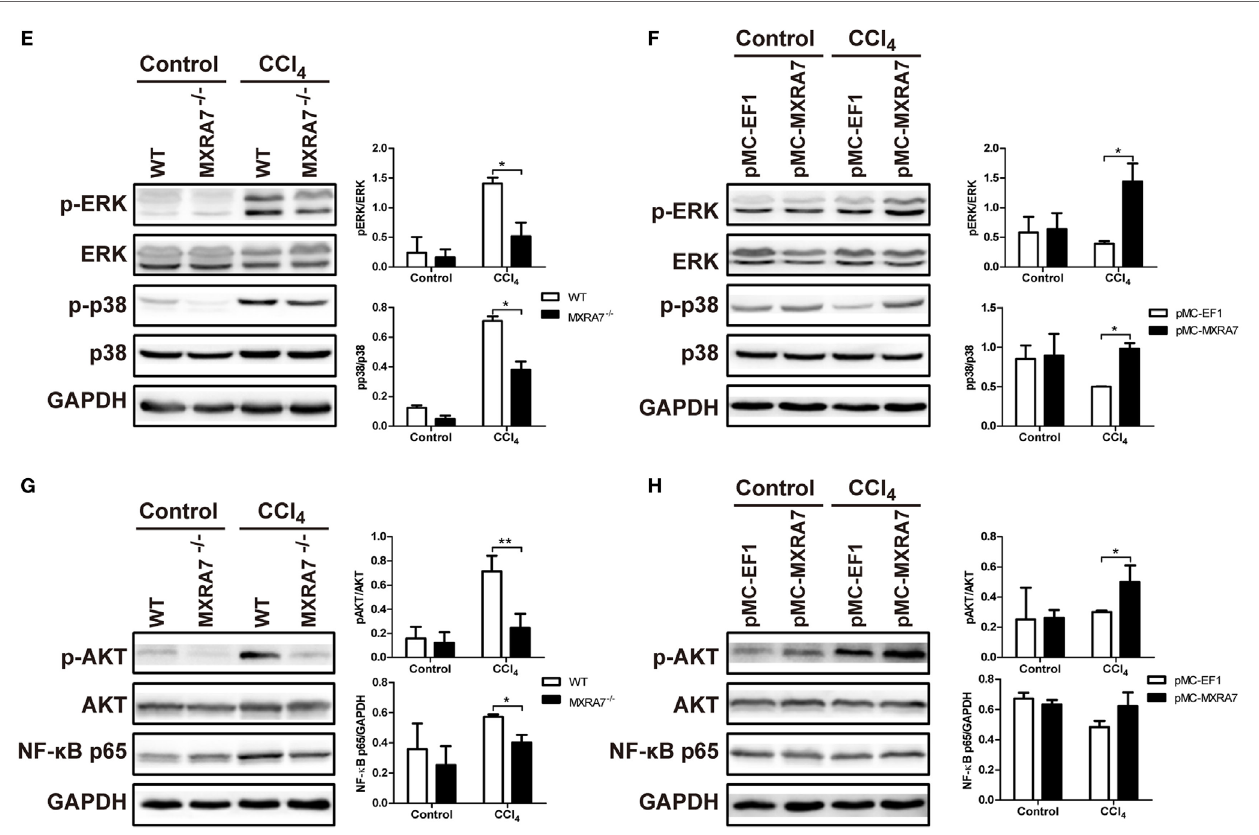
FigUre 7 | Matrix remodeling associated 7 (MXRA7) deficiency suppresses the cell apoptosis pathway and inflammatory pathway in livers. Livers were harvested from different groups of mice 24 h after 1 ml/kg CCl 4 injection. (a,B) Hepatocyte apoptosis in liver was analyzed using TUNEL staining (in red). Representative images from different groups are shown. Scale bar = 100 μ m. And proteins were extracted from livers for western blot analysis of Bax and Bcl-2 (c,D) p-ERK, ERK, p-p38, p38 (e,F) , p-AKT, AKT, and NF- κ B p65 (g,h) . Representative images shown are the representative of three independent experiments. * p < 0.05, ** p <